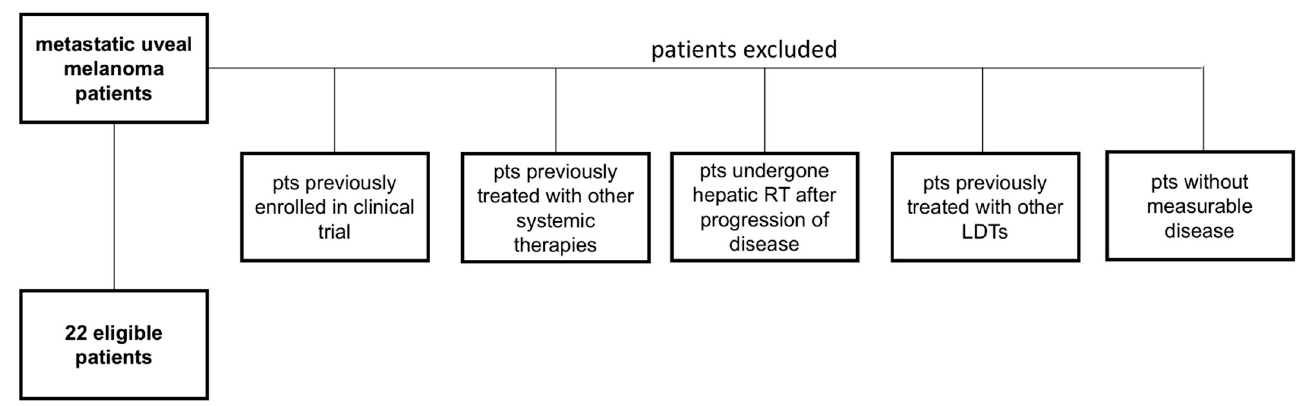
Figure 1. Patients’ selection process. The main characteristics excluding patients from the analysis are indicated. Pts: patients; RT: radiotherapy; LDTs: liver directed therapies.